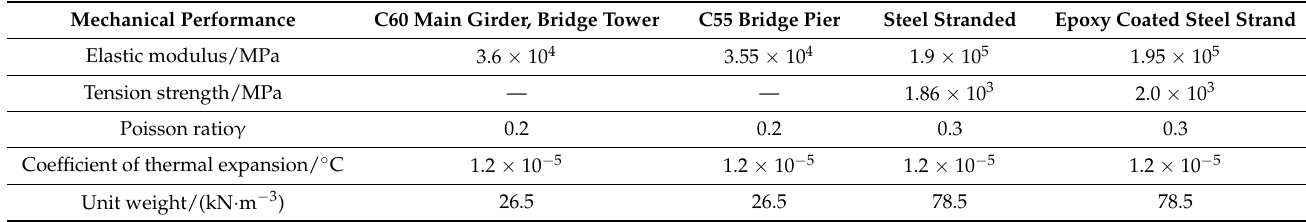
Table 1. Mechanical properties of finite element model materials.